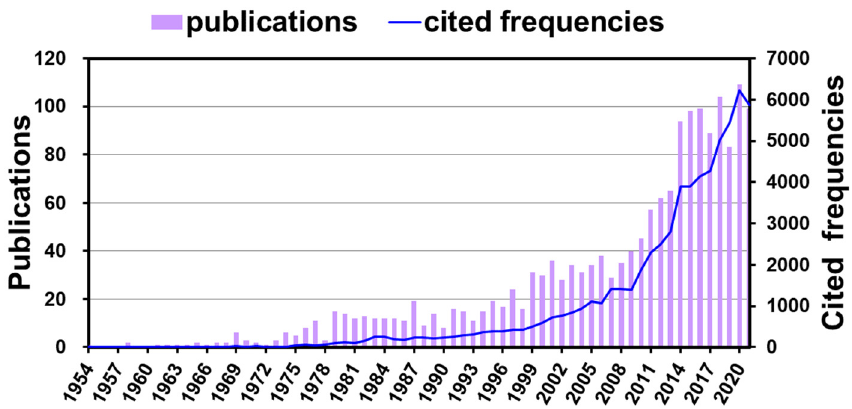
Figure 2. Publications and total cited frequencies associated with surface albedo from 1954 to 2021.